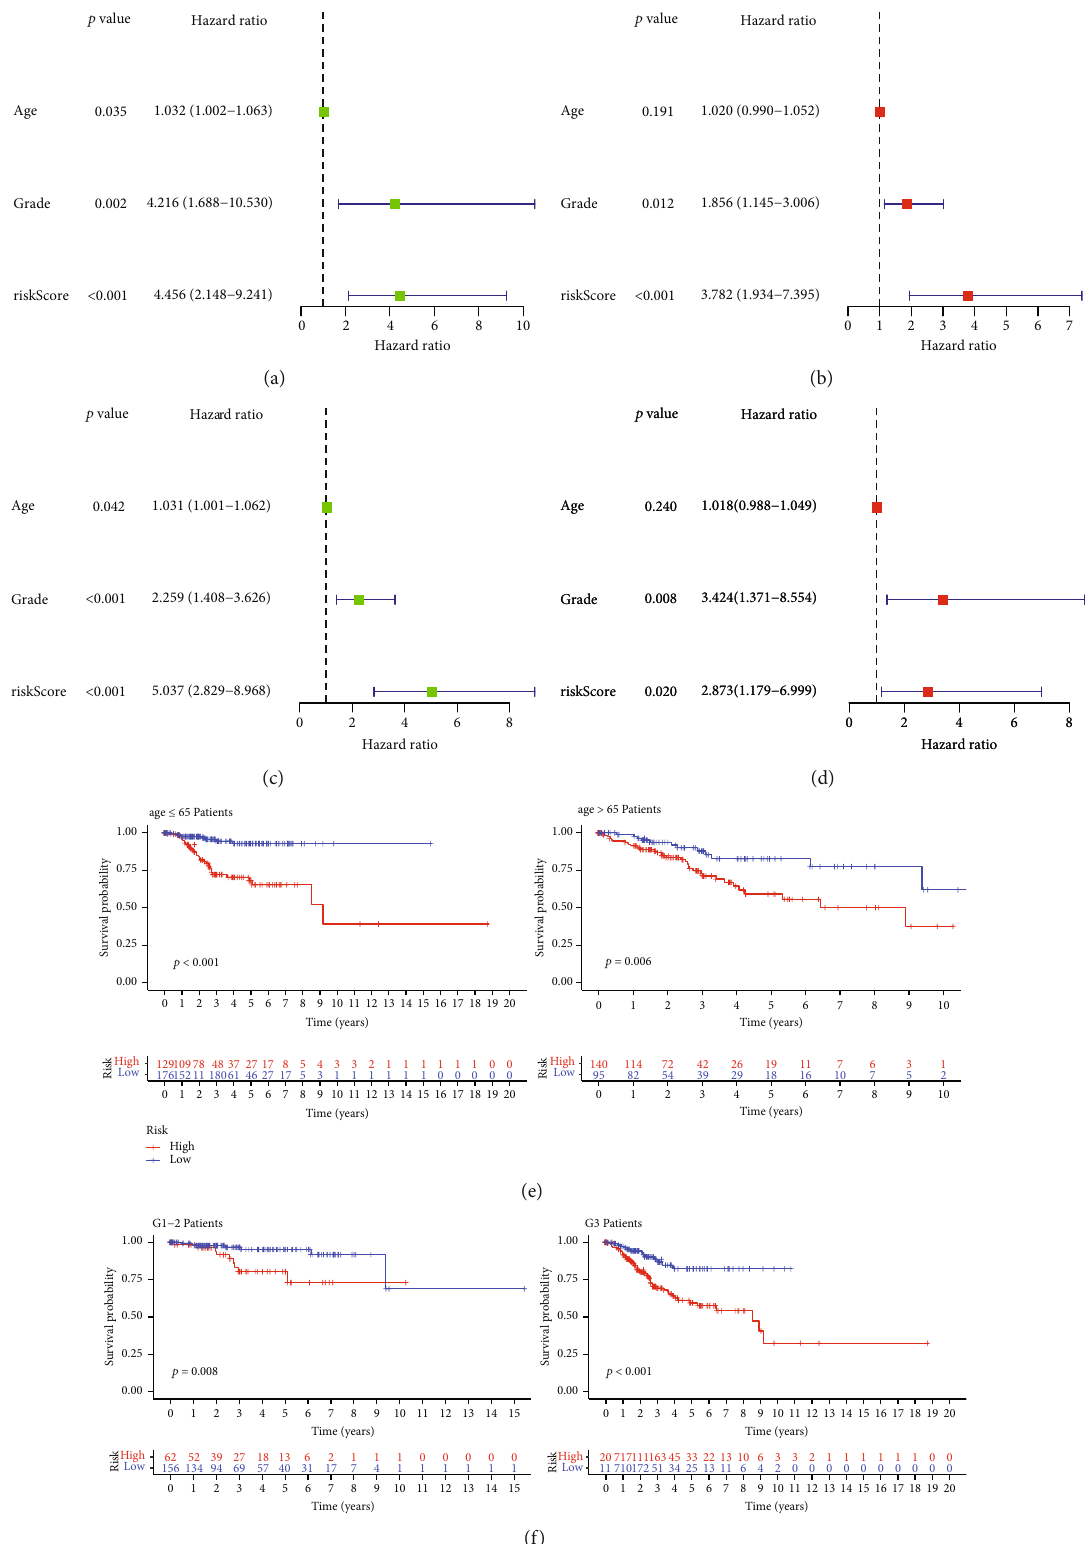
Figure 6: (a, b) Univariate Cox regression analysis of the training group and test group. (c, d) Multivariate Cox regression analysis of the training group and test group shown by forest maps. (e, f) Prognostic signi fi cance of the risk score in relation to varied clinicopathologic features: age and